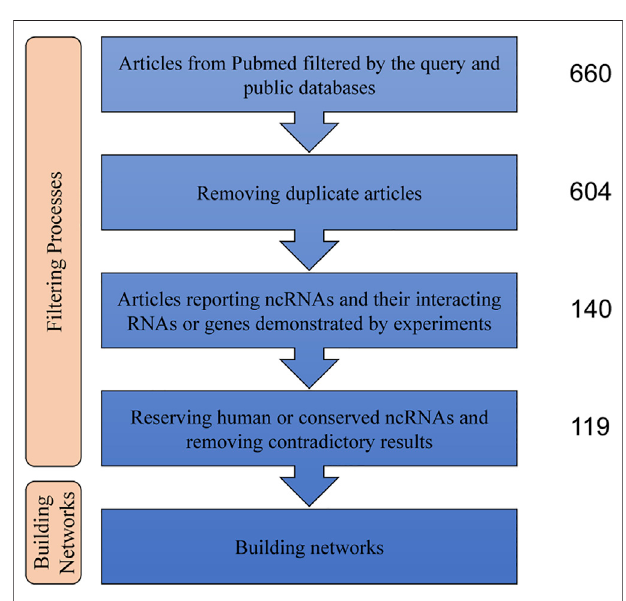
FIGURE 1 | Steps of the data analysis used to build the ncRNA networks. NcRNAs: non-coding RNAs.